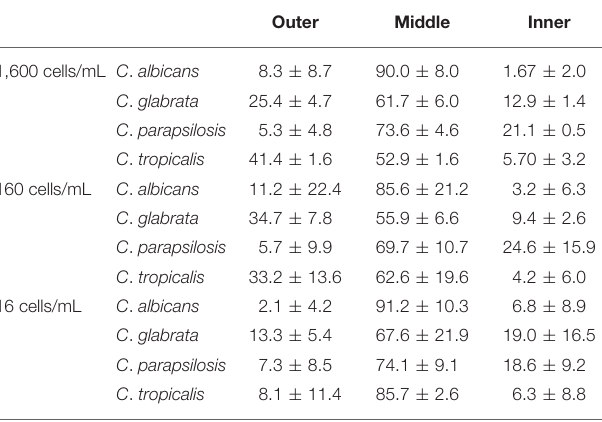
TABLE 2 | Percentage of recovered Candida species cells distributed among collection ports when using PBS as a flow